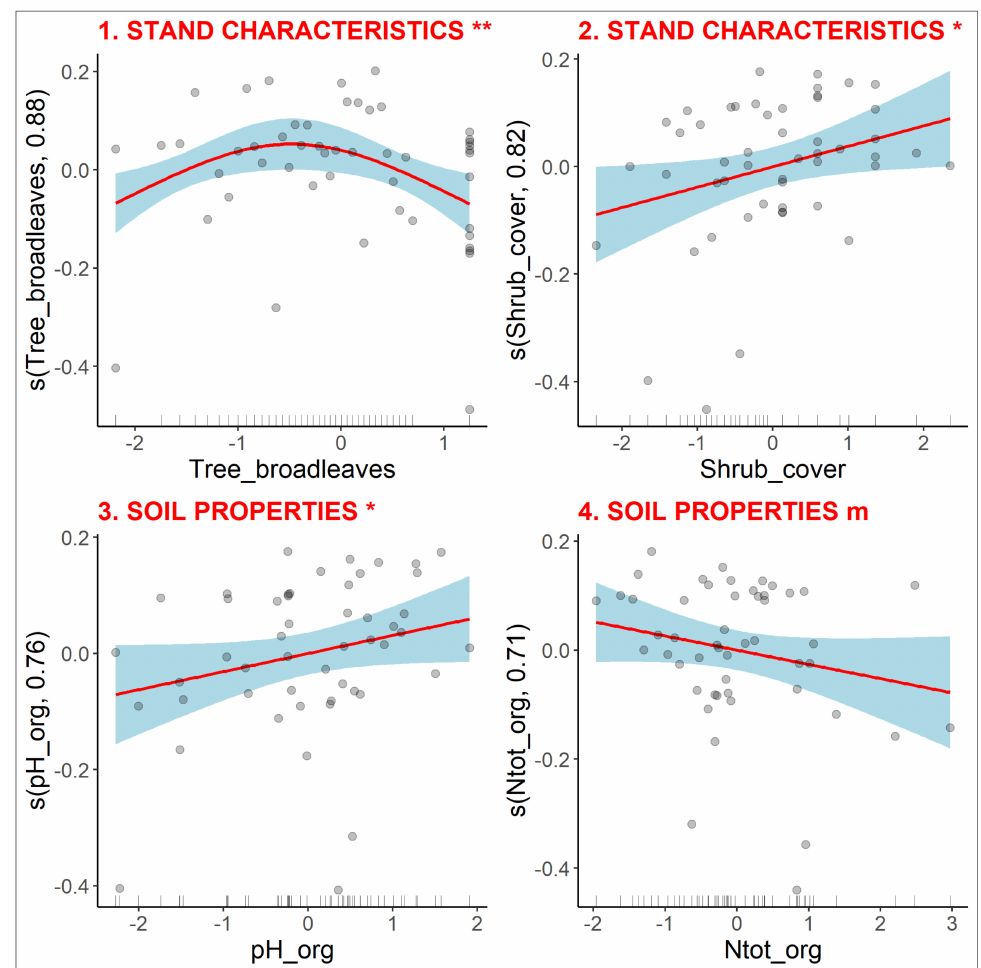
Figure 4. The estimated relationships between the herb-layer species evenness and four explanatory variables included in the final GAM: proportion of broadleaves in the tree layer, shrub layer cover, pH of the organic soil layer and total nitrogen content in the organic soil layer. The order of predictors reflects their effect size and significance: ** p < 0.01, * p < 0.05, m (marginally significant)— p < 0.1. The confidence interval (95%) is indicated with the light-blue ribbon around each curve. For additional definition of predictors, see Table